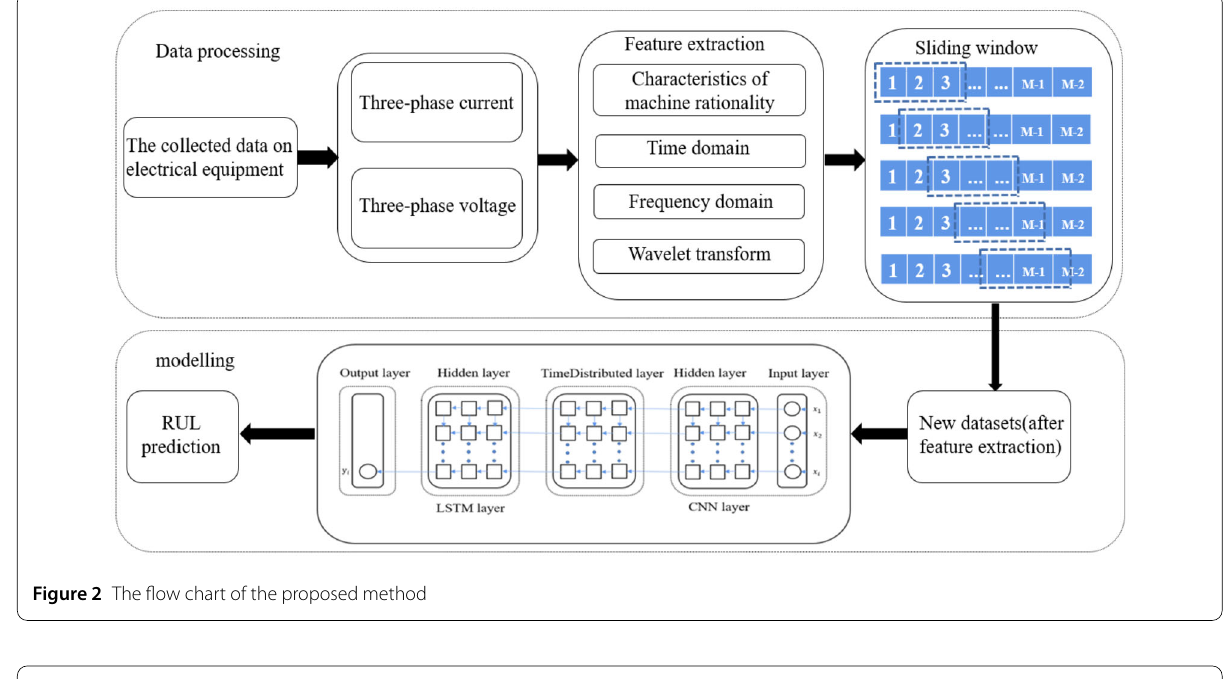
Figure 2 The flow chart of the proposed method